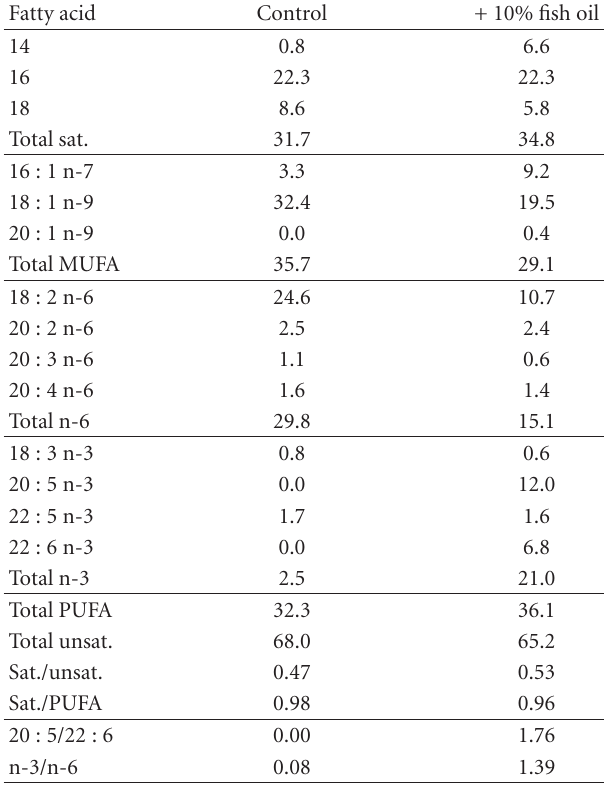
Table 1: Fatty acid composition of control and experimental diet. Fatty